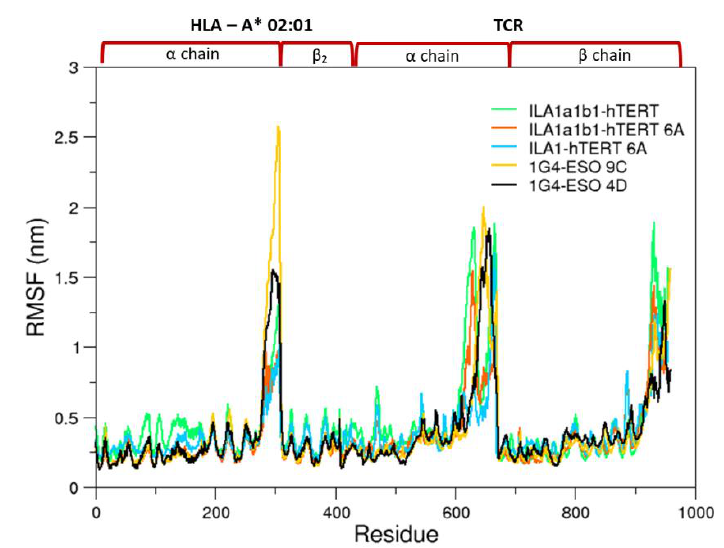
Figure 2. Root mean square fluctuation (RMSF) of the alpha carbon of the bound states. On top, the pMHC-TCR regions are reported.